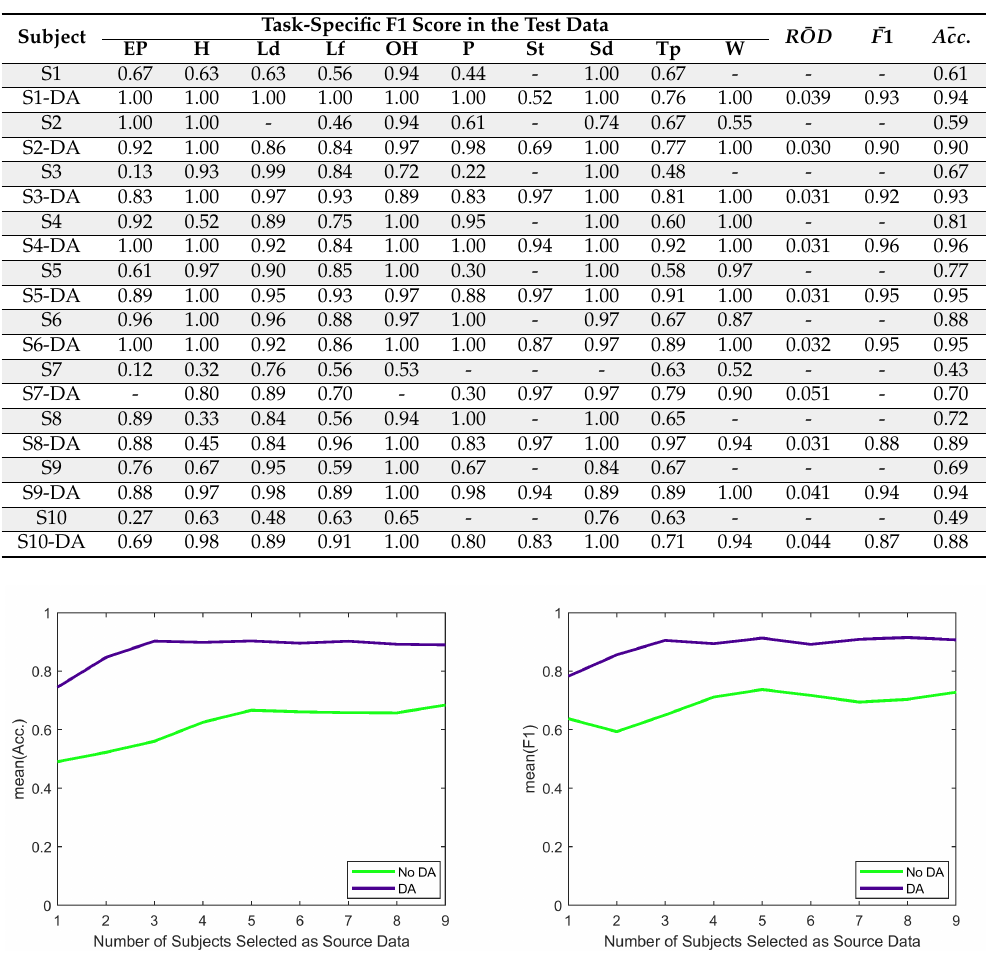
Table 6. Joint cross-sensor and cross-subject classification performance. Abbreviations: EP: electrical panel, H: hoisting, Ld: ladder, Lf: lifting; OH: overhead; P: pushing; St: sitting; Sd: standing; Tp: typing; W: walking (For some of the cases, “-” has been reported as task-specific F1 score, which means that the denominator of the precision or recall for that specific case was zero).